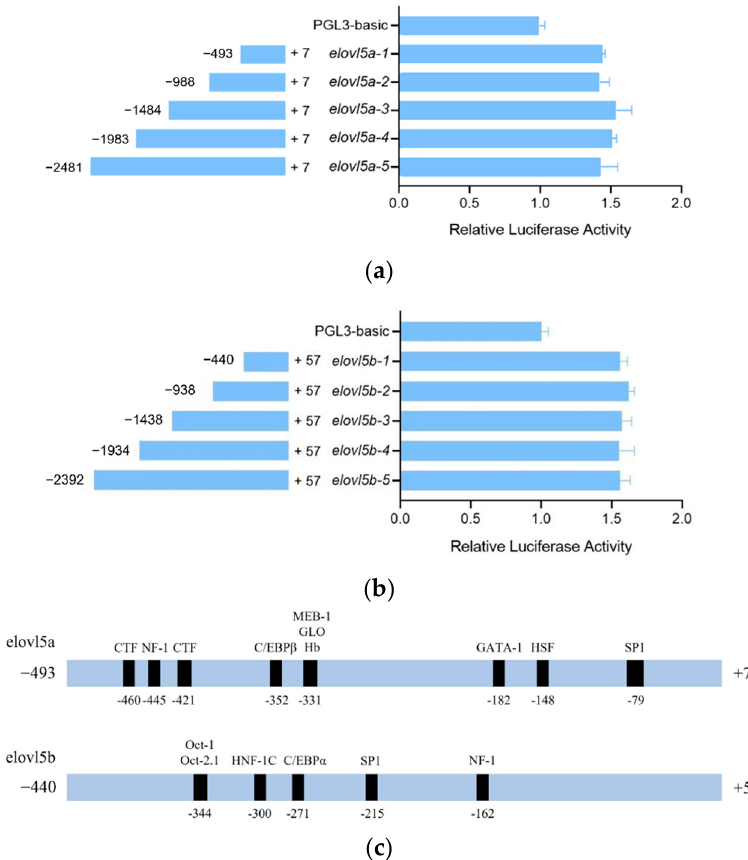
Figure 6. Promoter activity analysis of common carp elovl5a ( a ) and elovl5b ( b ). The results are reported as the mean ± SD. ( c ) The predicted TF binding sites in the core promoters of elovl5a and elovl5b. Many TFs had close binding sites.